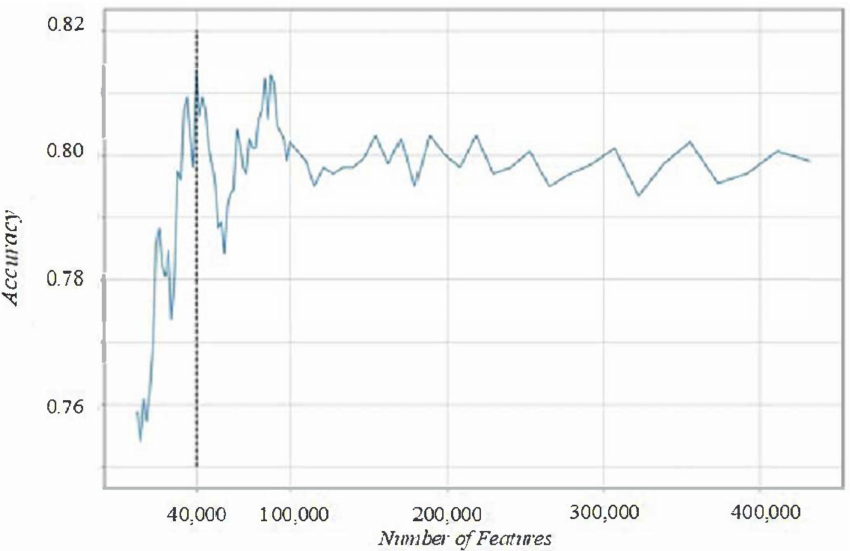
Figure 3. Prediction accuracy of logistic regression for symptom scores for top-k augmented features in chi-square statistic. As number of features (horizontal axis) increases, the accuracy initially increases rapidly and then reaches a plateau around 40,000 features (black vertical